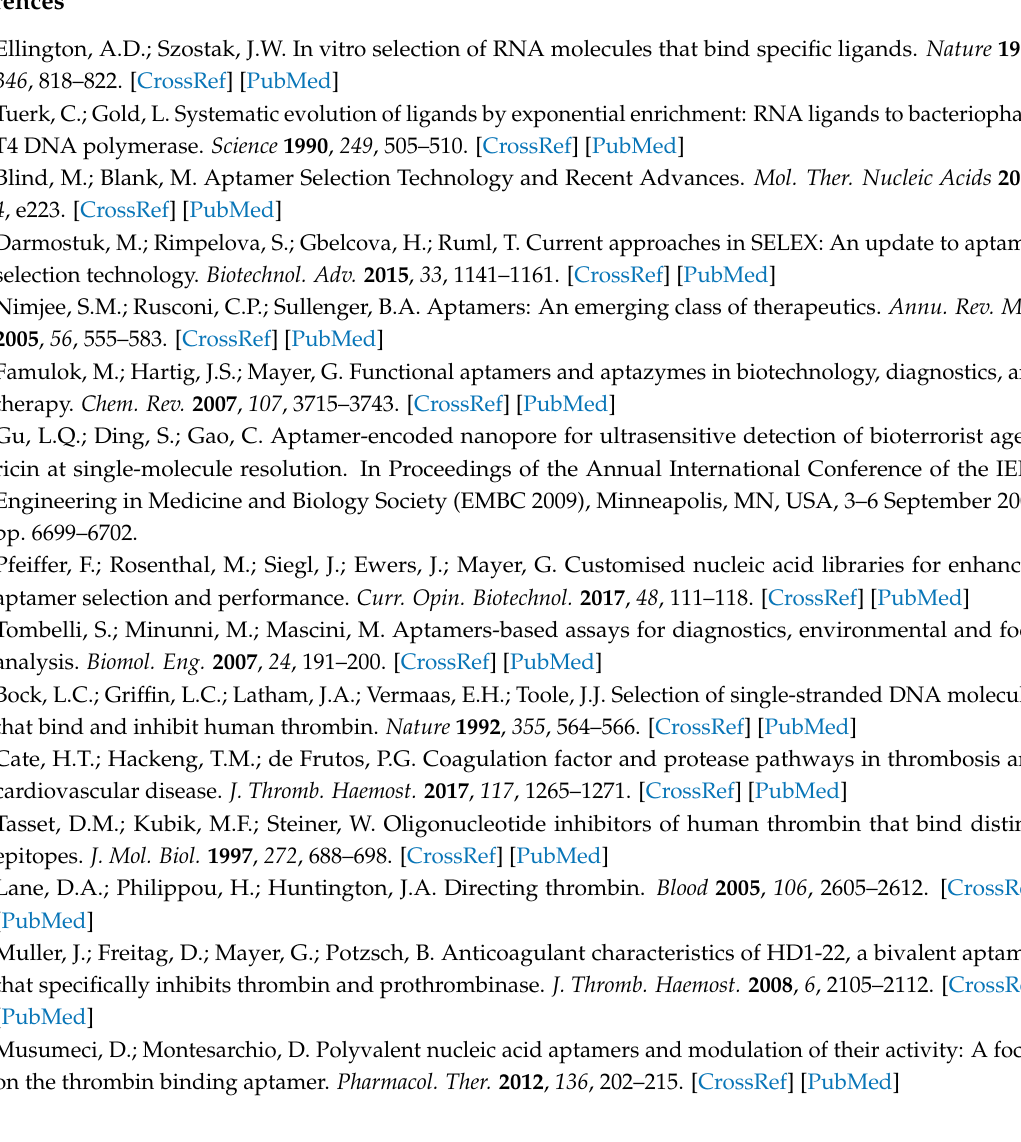
Supplementary Materials: Supplementary Materials are available online. Figure S1: Human serum degradation assay of the aptamers used in this